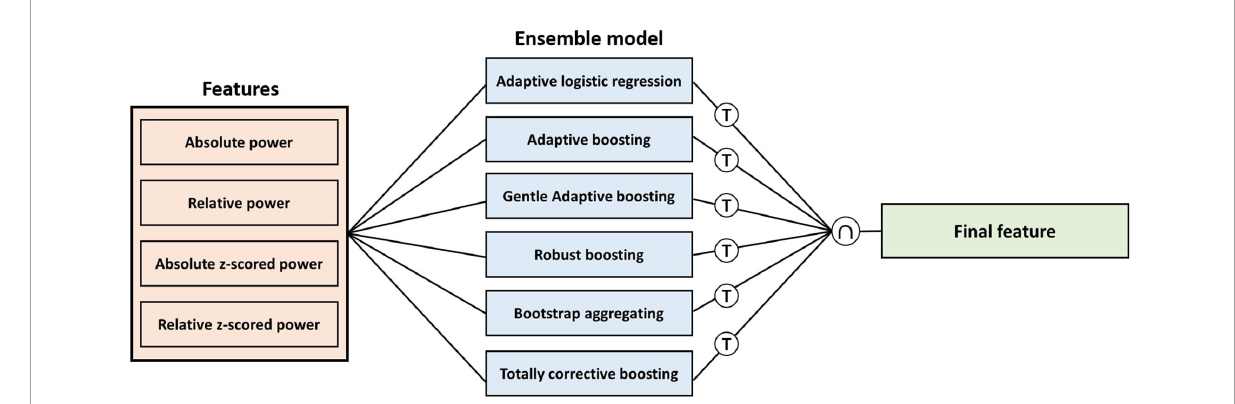
FIGURE2 Procedure of calculating feature importance for each feature in each ensemble model. T means threshold of the number of the highest score features for each model, and ∩ means intersection for the highest feature in each model.